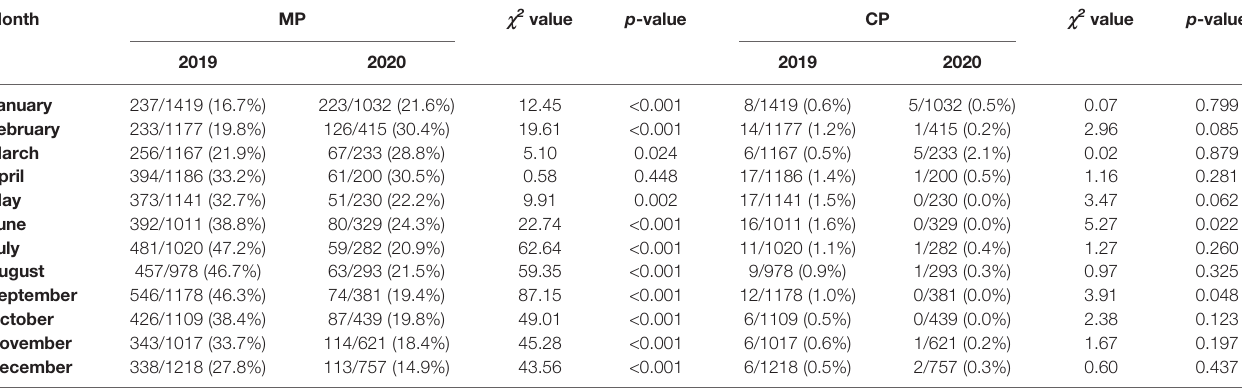
TABLE 3 | Detection of Mycoplasma pneumoniae and Chlamydia pneumoniae based on months between 2020 (during the COVID-19 pandemic) and 2019 (before the COVID-19 pandemic). MP c 2 value p -value